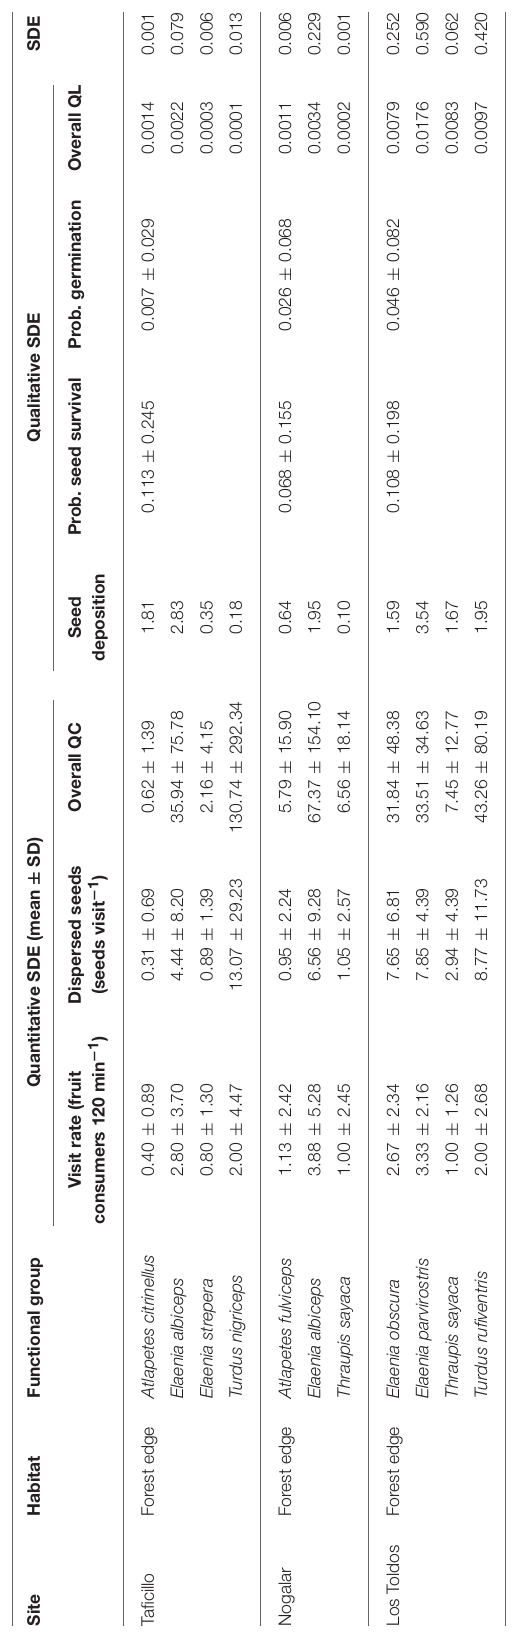
TABLE 5 | Result of mixed general linear model analyzing bird functional traits that affect the QC of SDE. Parameter Factor df